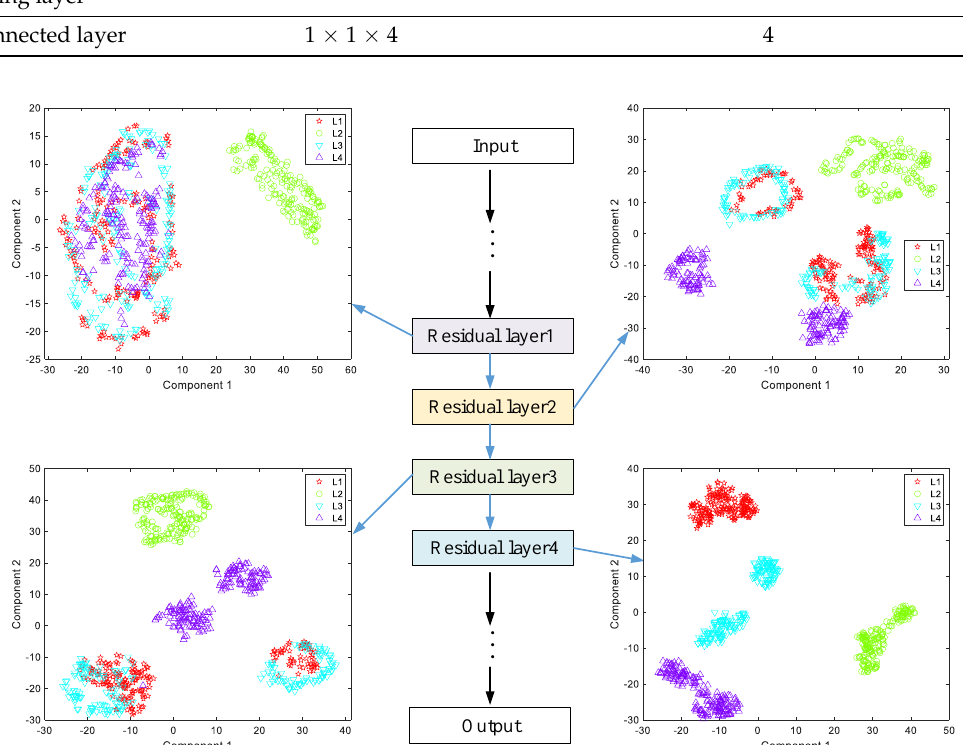
Figure 12. The t−SNE visualization analysis of the VMD−ResNet18 network for feature extraction. Figure 12. The t − SNE visualization analysis of the VMD − ResNet18 network for feature Table 7. The pre-training diagnostic results of the VMD-ResNet18.